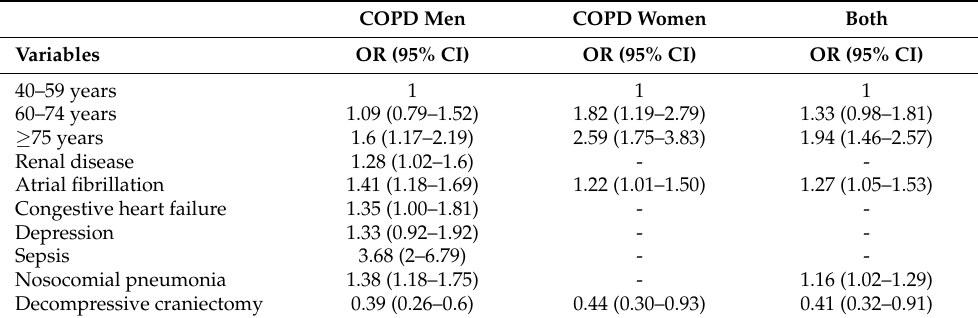
Table 5. Multivariable logistic regression analysis of factors associated with in hospital mortality among COPD patients with HS according to sex. COPD Men COPD Women Both